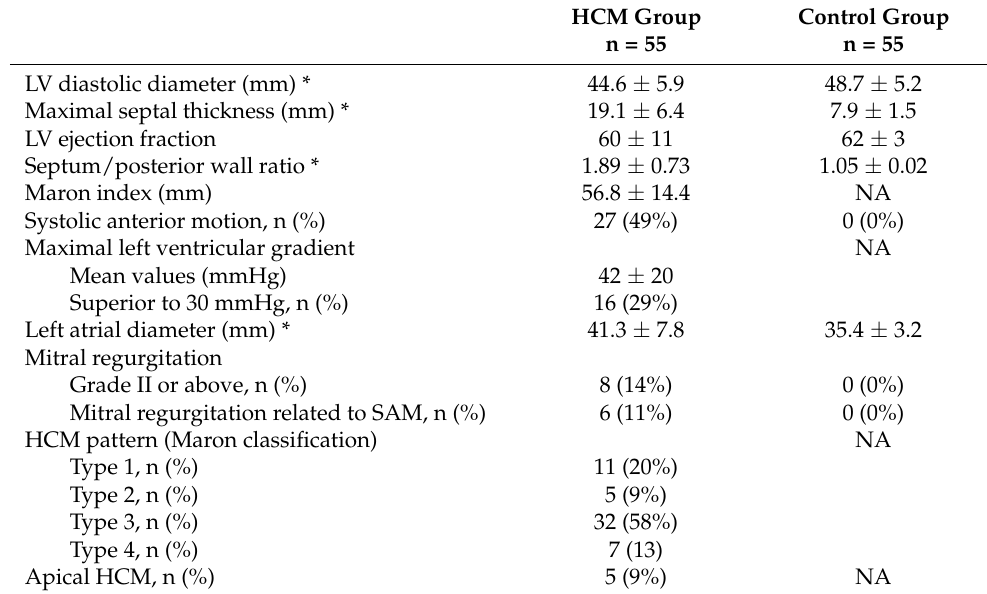
Table 2. Echocardiographic characteristics of HCM and control